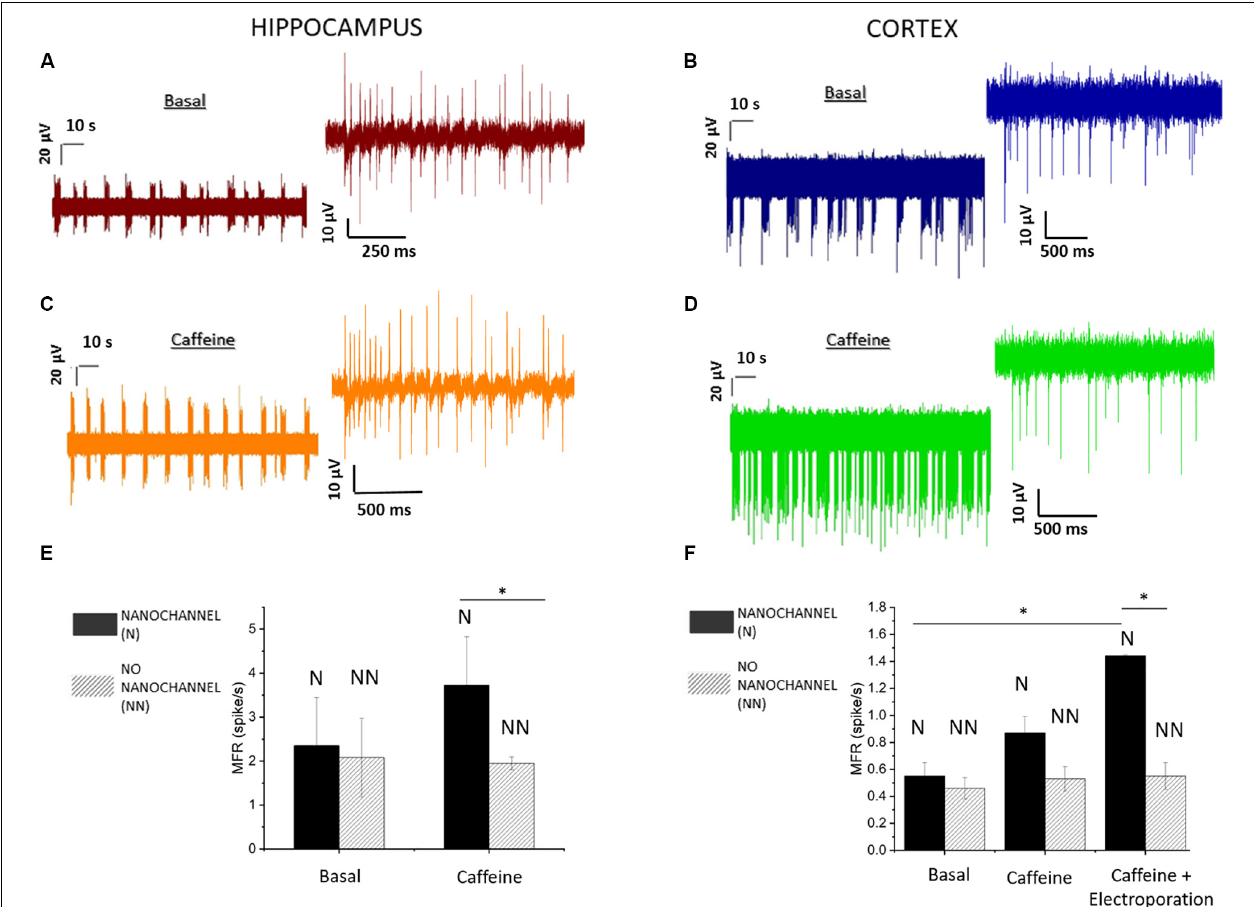
FIGURE 3 | Hippocampal and cortical neuronal network recording and analysis. (A) Activity of hippocampal (20 DIV) neurons before and (C) after the caffeine injection. (B) Activity of cortical (21 DIV) neurons before and (D) after the caffeine injection. (E) Mean firing rate (MFR) of hippocampal neurons. Comparison between electrodes with (solid) and without (dashed) nanochannels in basal ( p > 0.8) and caffeine conditions. (F) MFR in basal ( p > 0.8), caffeine, and caffeine + electroporation conditions in cortical neurons for both electrodes (with and without nanochannels). Data are represented as mean ± SEM. Asterisks above the plots indicate statistical significance (*0.01 < p <